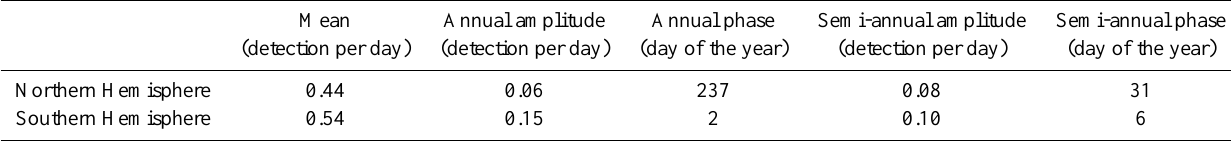
Table 1. Harmonic analysis of the Pc1 annual variations, as shown in Fig. 5, separately for the two